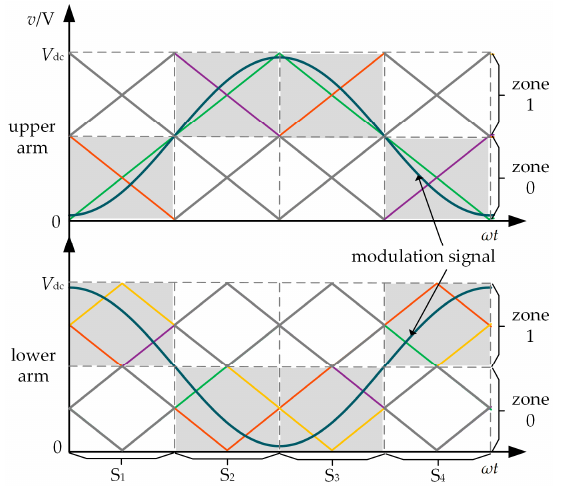
Figure 6. The principle of the improved 2 N +1 pulse-width modulation approach ( N = 4).